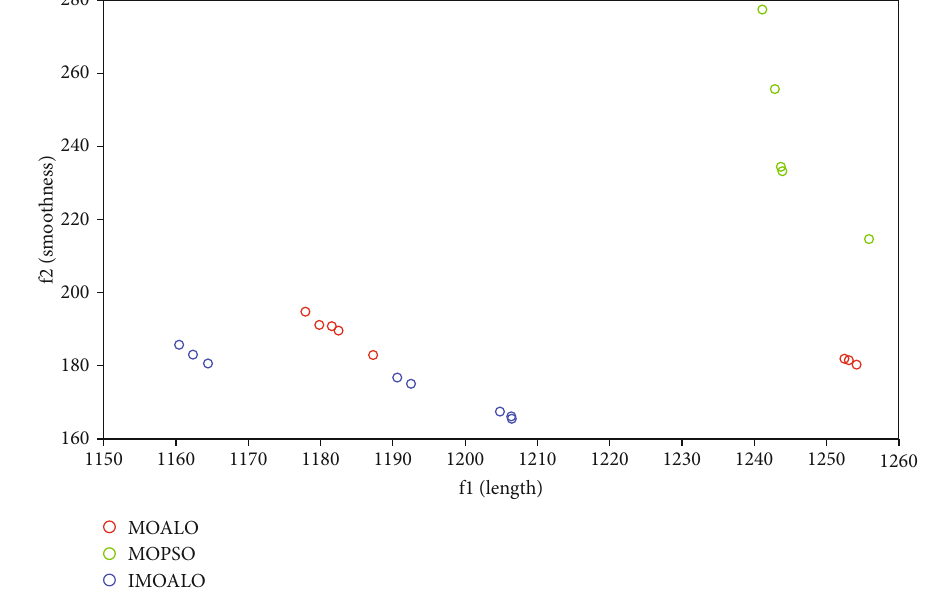
Figure 9: Pareto solution distribution.